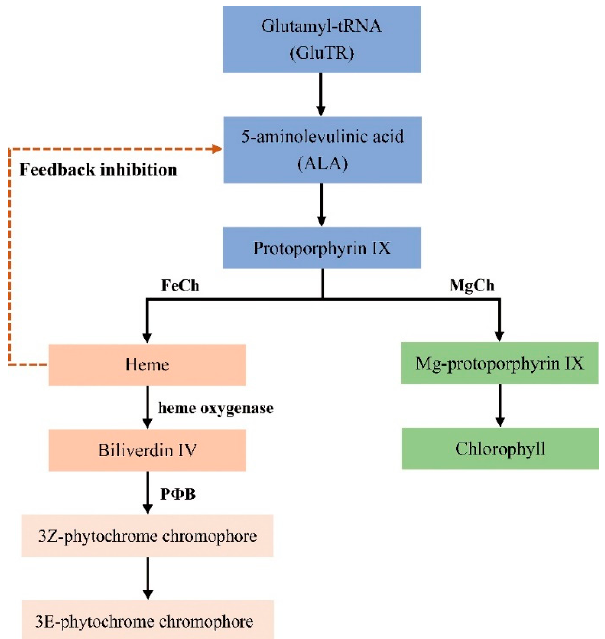
Figure 3. Heme metabolism pathway in high plants. The 3Z-phytochrome chromophore could spontaneously form a 3E-phytochrome chromophore or be an enzyme catalyst.